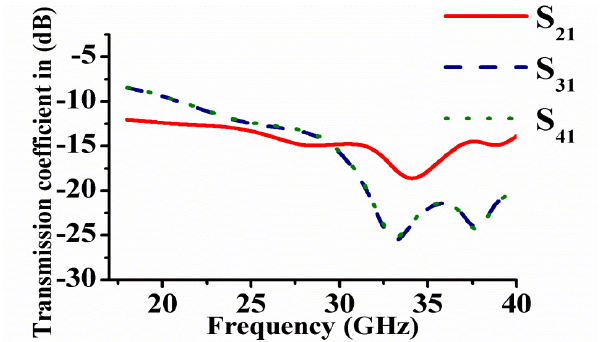
Figure 4: Transmission coefficients of the proposed pattern diversity antenna when it is fed through Port 1.